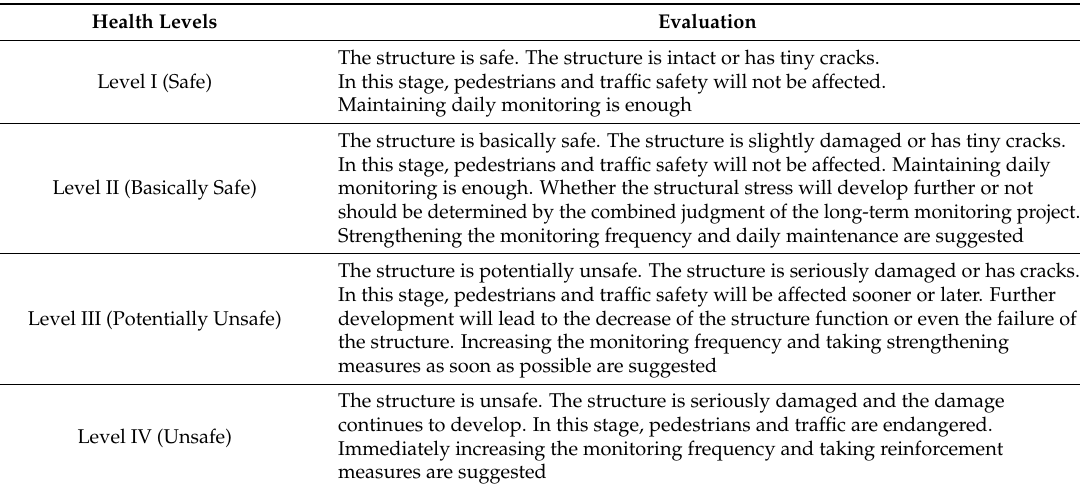
Table 2. Health levels of a tunnel